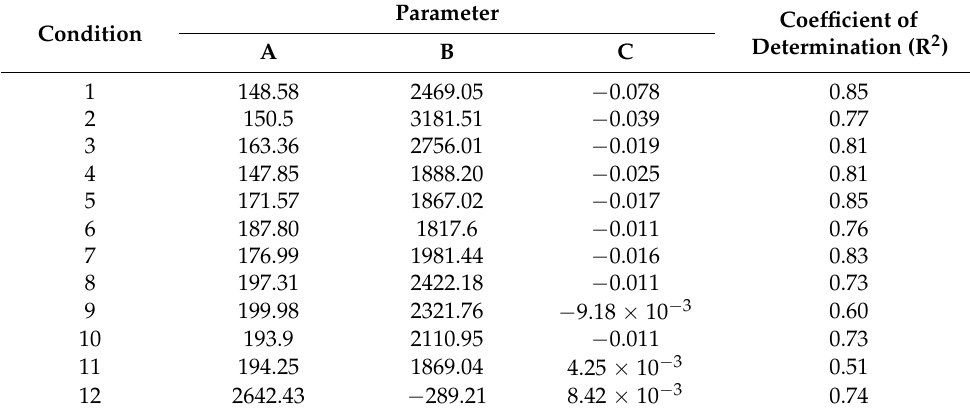
Table 4. Parameter values obtained using nonlinear regression according to Equation (6).